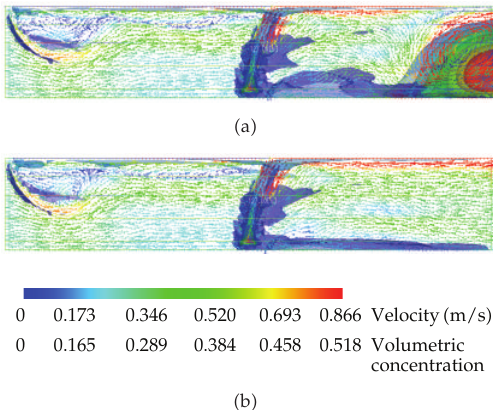
Figure 9: Combined velocity vector and isosurface plots for Model 3 at t (cid:8) 127s. (cid:2) a (cid:3) Slip in the x -direction, (cid:2) b (cid:3) slip in the x -direction and C (cid:8) 0 at the tunnel outlet. The colour bar applies both figures.